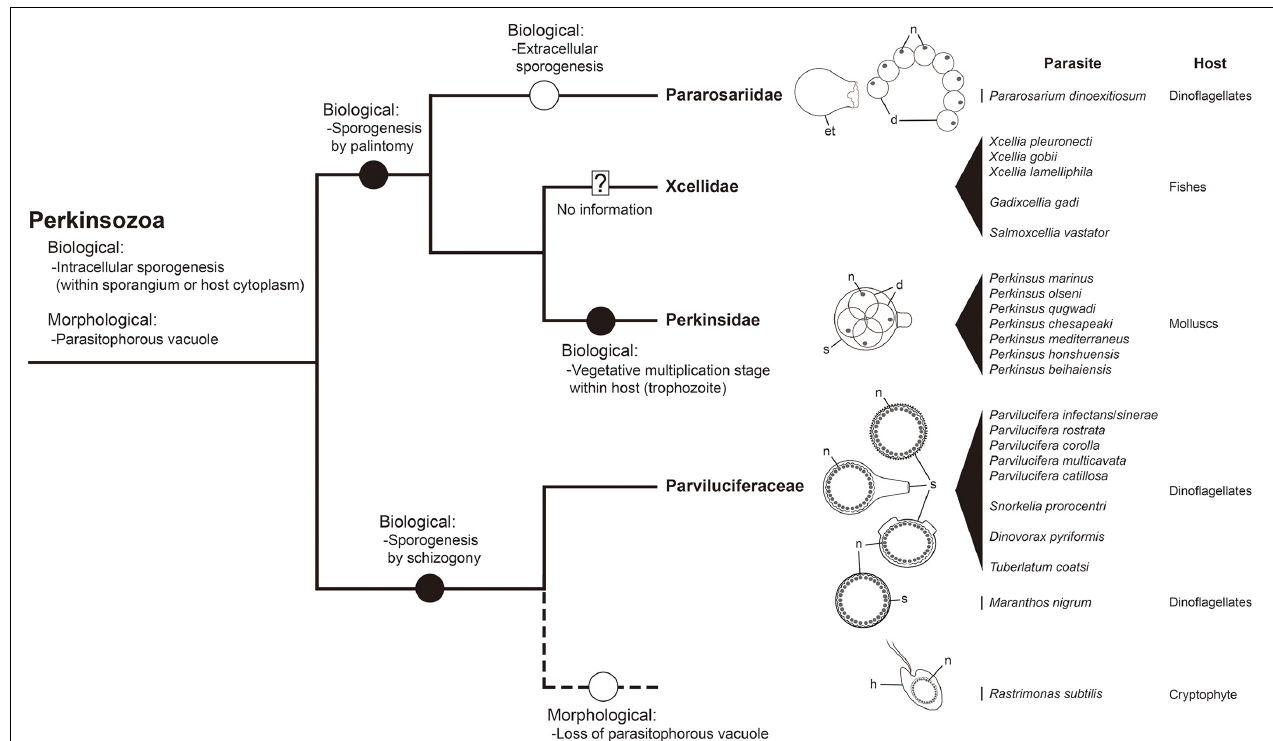
FIGURE 9 | A framework for inferring biological and morphological characters evolution in the phylum Perkinsozoa. Evolution of biological and morphological characters is considered relative to the combined small and large subunit (SSU and LSU) rDNA phylogeny at the family level. Highlighted circles in branches denote positions of relevant character states as constrained by parsimony. Question mark: no detailed information on life cycle and morphology; dashed line: phylogenetic uncertainty due to unavailable sequence; et, empty trophocyte wall; d, daughter cell (sporocytes); h, host; n, nucleus; s, sporangium.